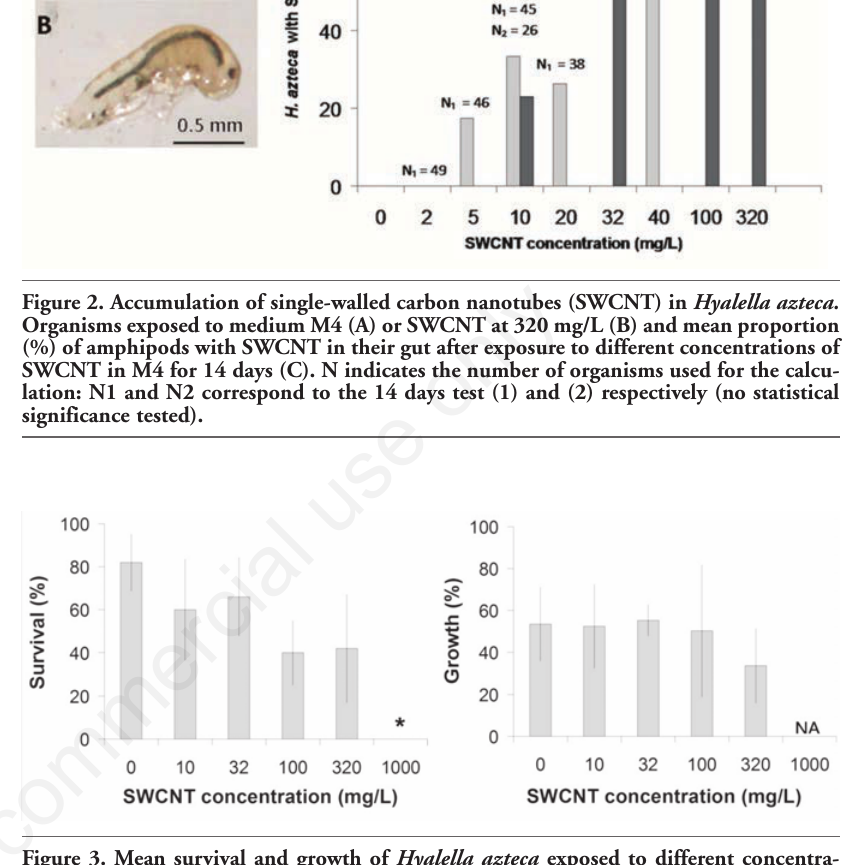
Figure 3. Mean survival and growth of Hyalella azteca exposed to different concentra- tions of single-walled carbon nanotubes (SWCNT) in M4 for 14 days. Each column is the mean of 5 replicates ± standard deviation and * indicates significant difference of group exposed compared to the negative control. NA; not applicable due to no survival.